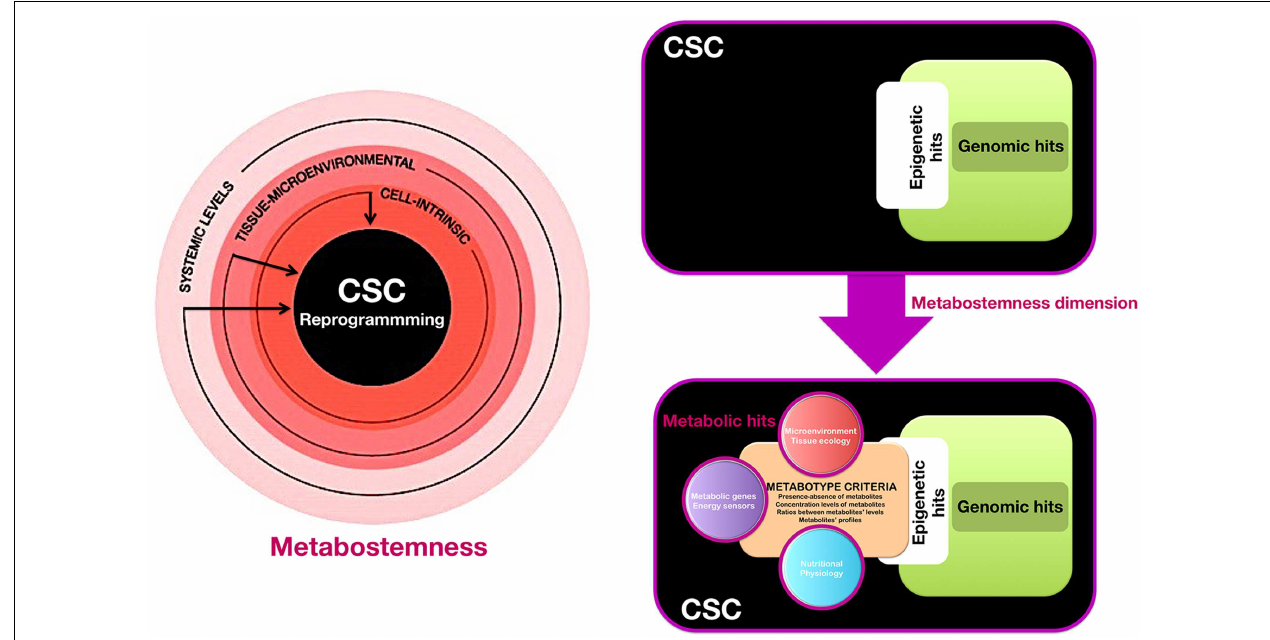
FIGURE 1 | Metabostemness: a new-dimensional cancer hallmark .We have recently hypothesized that CSC-driven malignant progression might be envisioned as an evolving spatio-temporal heterogeneous structure that might not be driven solely by irreversible genomic hits but also by metabolic means; thus, the acquisition of, and departure from, stemness in cancer tissues might be governed not only by transcriptional and epigenetic controllers but also by the pivotal regulatory role of metabolic reprograming in cell-fate decisions. In this scenario, we propose the actual existence of a new phenomic